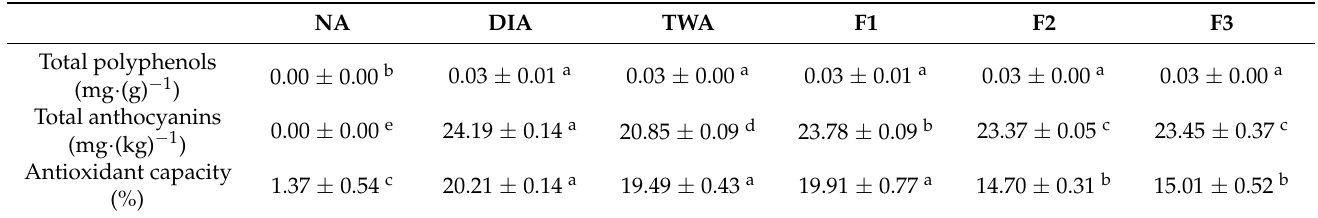
Table 3. Total polyphenols content, total anthocyanins content, and antioxidant capacity of the steamed cold noodles that were not colored (NA), colored with deionized water-dissolved BRA (DIA), colored with tap water-dissolved BRA (TWA), and colored with tap water-dissolved BRA containing the three optimized chelator formulations